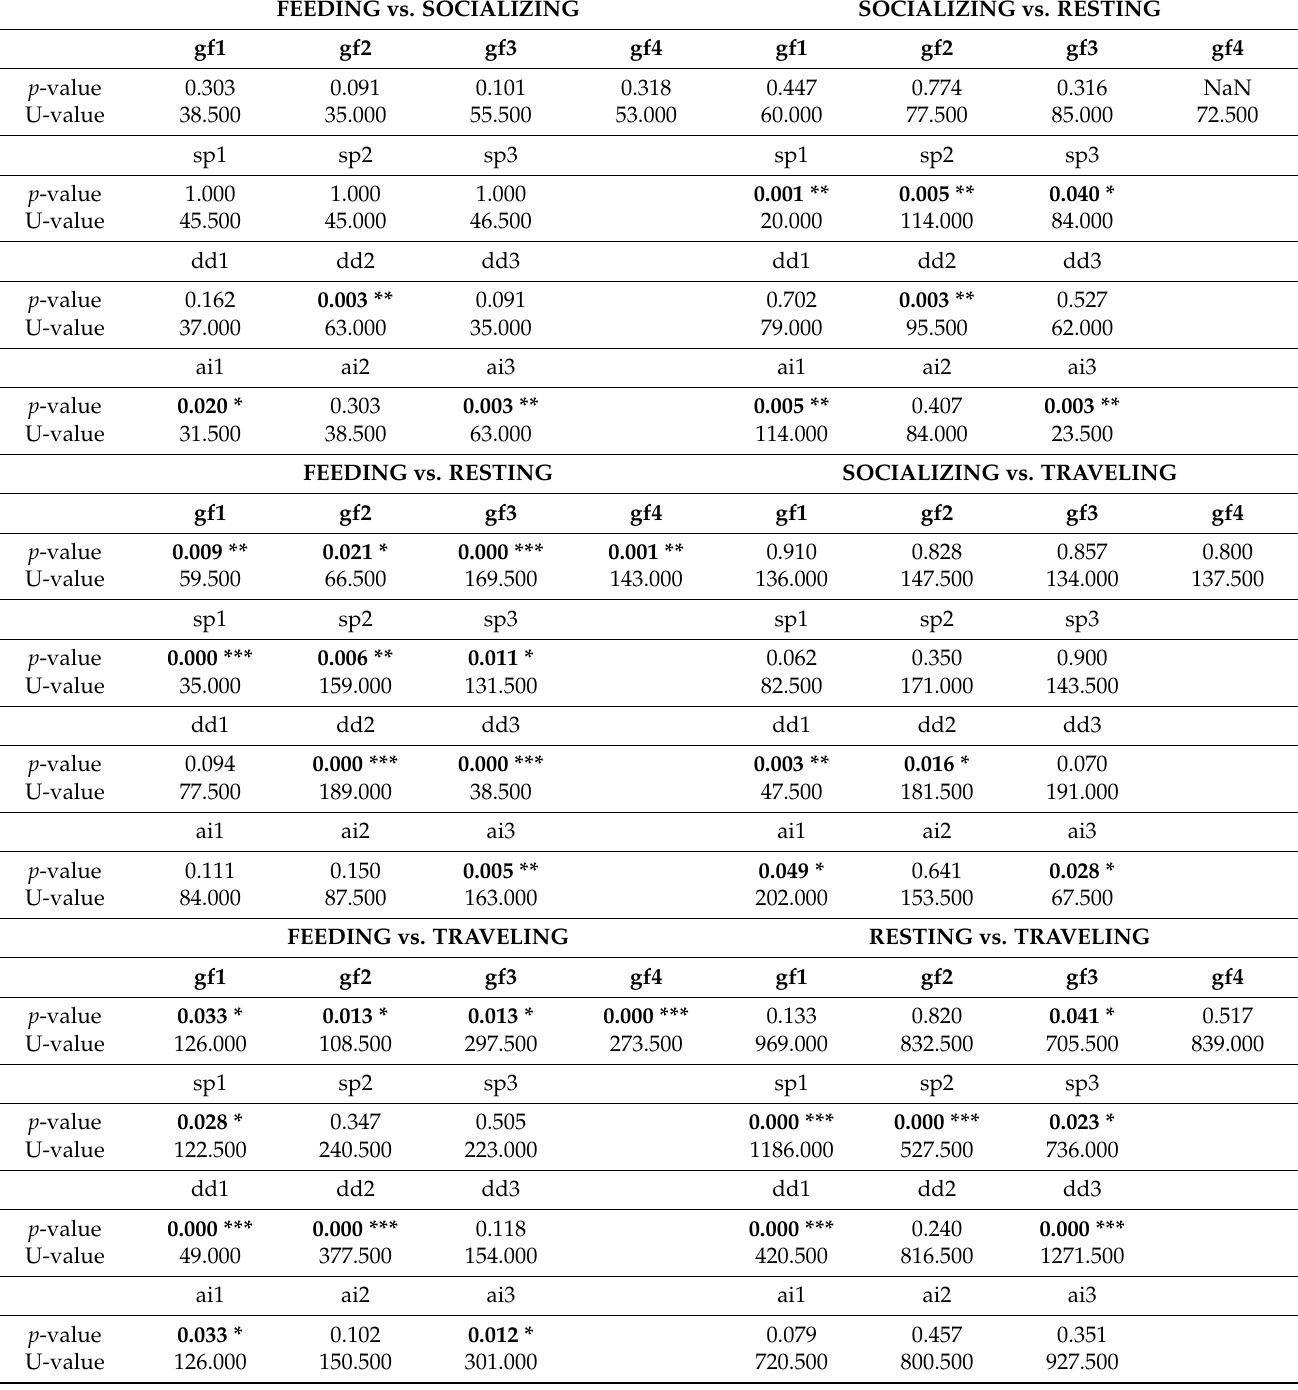
Table 3. Results of Mann–Whitney test (U) performed under the null hypothesis that group forma- tion (gf), cruising speed (sp), dive duration (dd) and interaction among individuals (ai) were not significantly different between activity states. p - and U-values were reported. Significant values were reported in bold and asterisks indicate the significance level: * p -value < 0.05; ** p -value < 0.01; *** p -value <